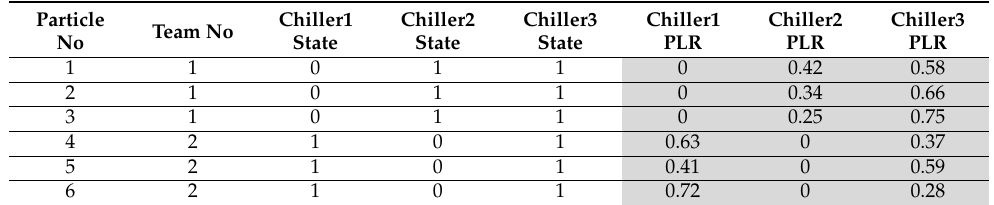
Table 5. Step 5: the team evolution for on-off states of chillers.